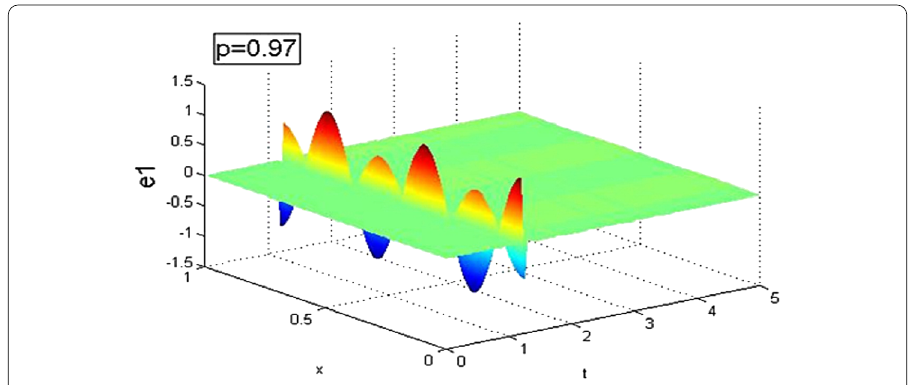
Figure 3 Time evolution of the nonlinear synchronization control error e 1